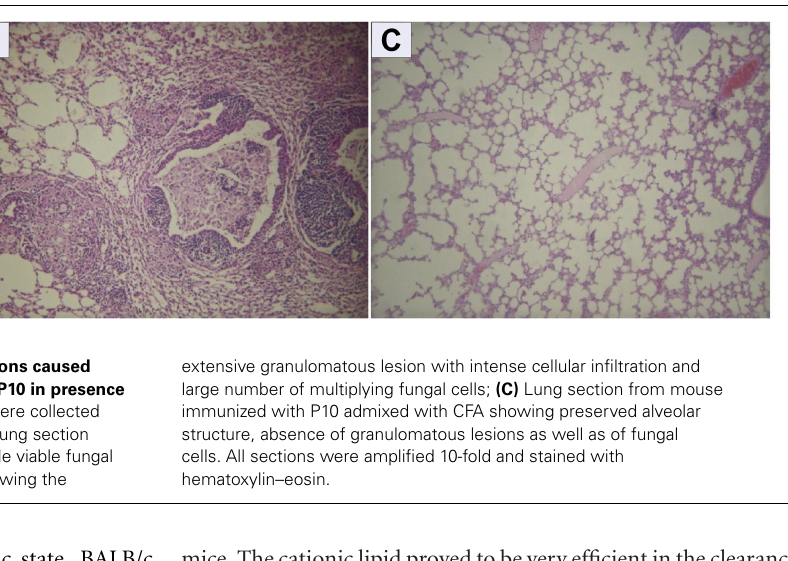
extensive granulomatous lesion with intense cellular infiltration and large number of multiplying fungal cells; (C) Lung section from mouse immunized with P10 admixed with CFA showing preserved alveolar structure, absence of granulomatous lesions as well as of fungal cells. All sections were amplified 10-fold and stained with